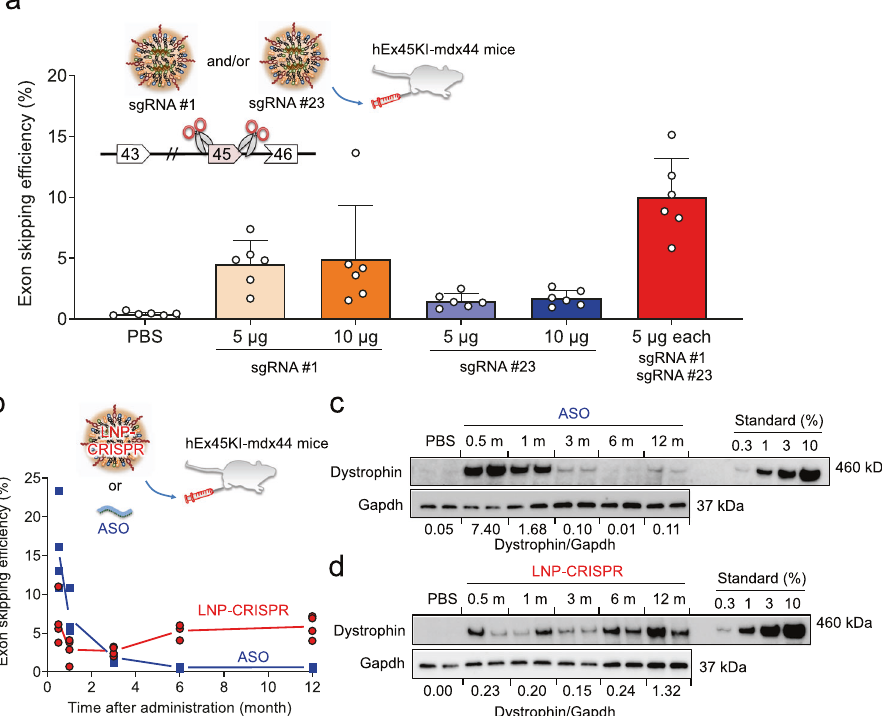
Fig. 4 LNP delivery of dual sgRNAs into humanized model mice restored dystrophin protein over 12 months. a Effect of dual sgRNA combination on exon skipping ef fi ciency. A week after the single administration of LNPs encapsulating 10 μ g of Cas9 mRNA and the indicated amounts of sgRNA(s) and mRNA from TA in hEx45KI-mdx44 mice ( n = 6 mice) was assessed by qRT-PCR. Data are represented as means ± S.D. b Long-term effect of exon skipping was measured by qRT-PCR in GC after a single injection of ASO (phosphorodiamidate morpholino oligomer) or LNP-CRISPR (sgRNA #1 + #23) into hEx45KI-mdx44 mice. Each dot represents data from an individual mouse, and average values from each time point ( n = 4 mice) are connected by a solid line to show the trend of each group over time. c , d The recovered dystrophin level was assessed by Western blotting in TA after a single intramuscular administration of ASO ( c ) or LNP-CRISPR ( d ). Numbers below the WB images shows relative amount of dystrophin expression normalized by Gapdh amount at each time point. n = 4 mice per each time point, but only two mice of Western blot images are